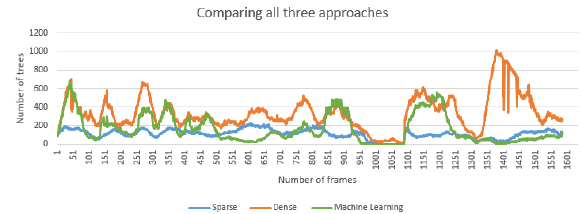
Figure 19 Combined Approach (Dense And Sparse) Count Vs Manual Count.